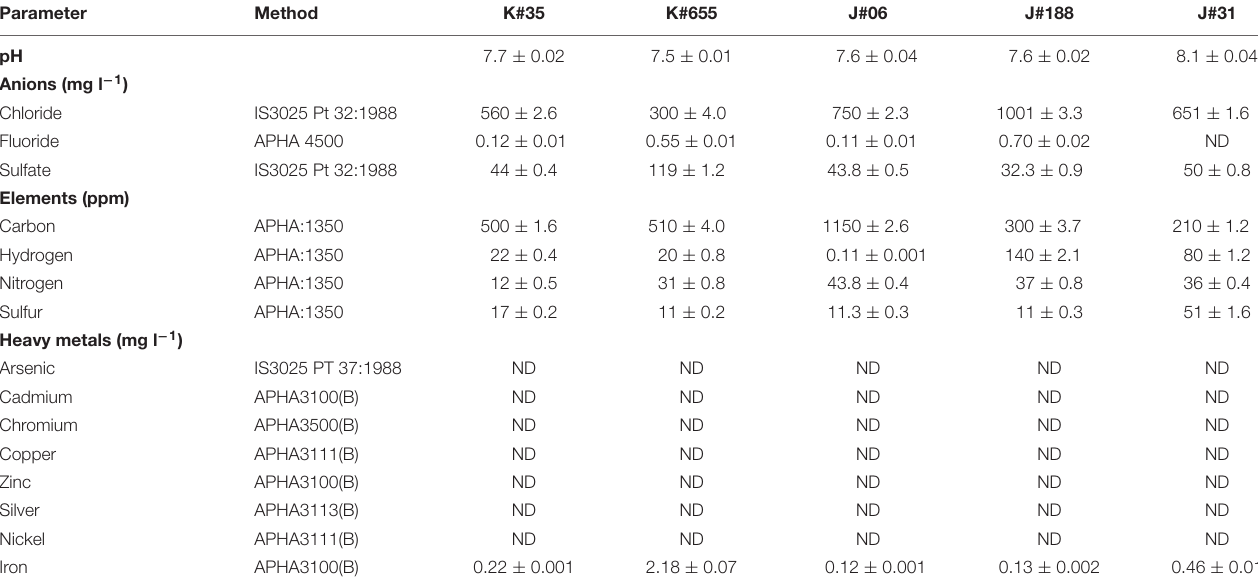
TABLE 2 | Physico-chemical analysis of formation water collected from Gujarat oil fields.